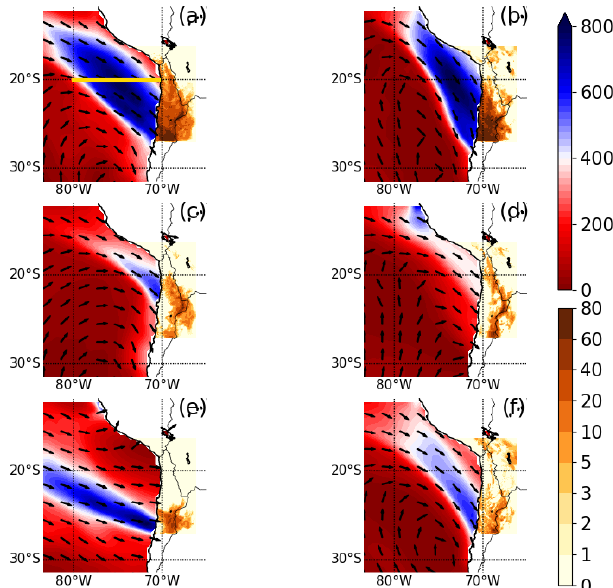
Figure 5. Daily rainfall over land (green–blue shading, in mmd − 1 ) during top winter events in WRF mP (obtained for the inner model domain with 10km resolution) and the maximum upper-level IWVF (above 2000ma.g.l.) over ocean (arrows and red–blue shading, in kgm − 1 s − 1 ) on the day of or the day prior to the rainfall event (obtained from the outer model domain with 50km resolution). (a, b) Events which are among the top events of both the northern and southern Atacama Desert. (c, d) Events which are only among the top events of the northern Atacama Desert. (e, f) Events which are only among the top events of the southern Atacama Desert.